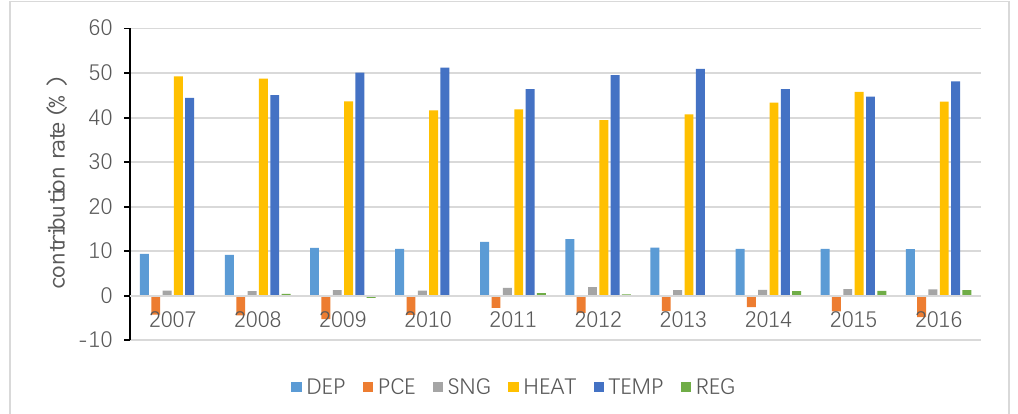
Figure 5. Decomposition result of URECP by GE1.